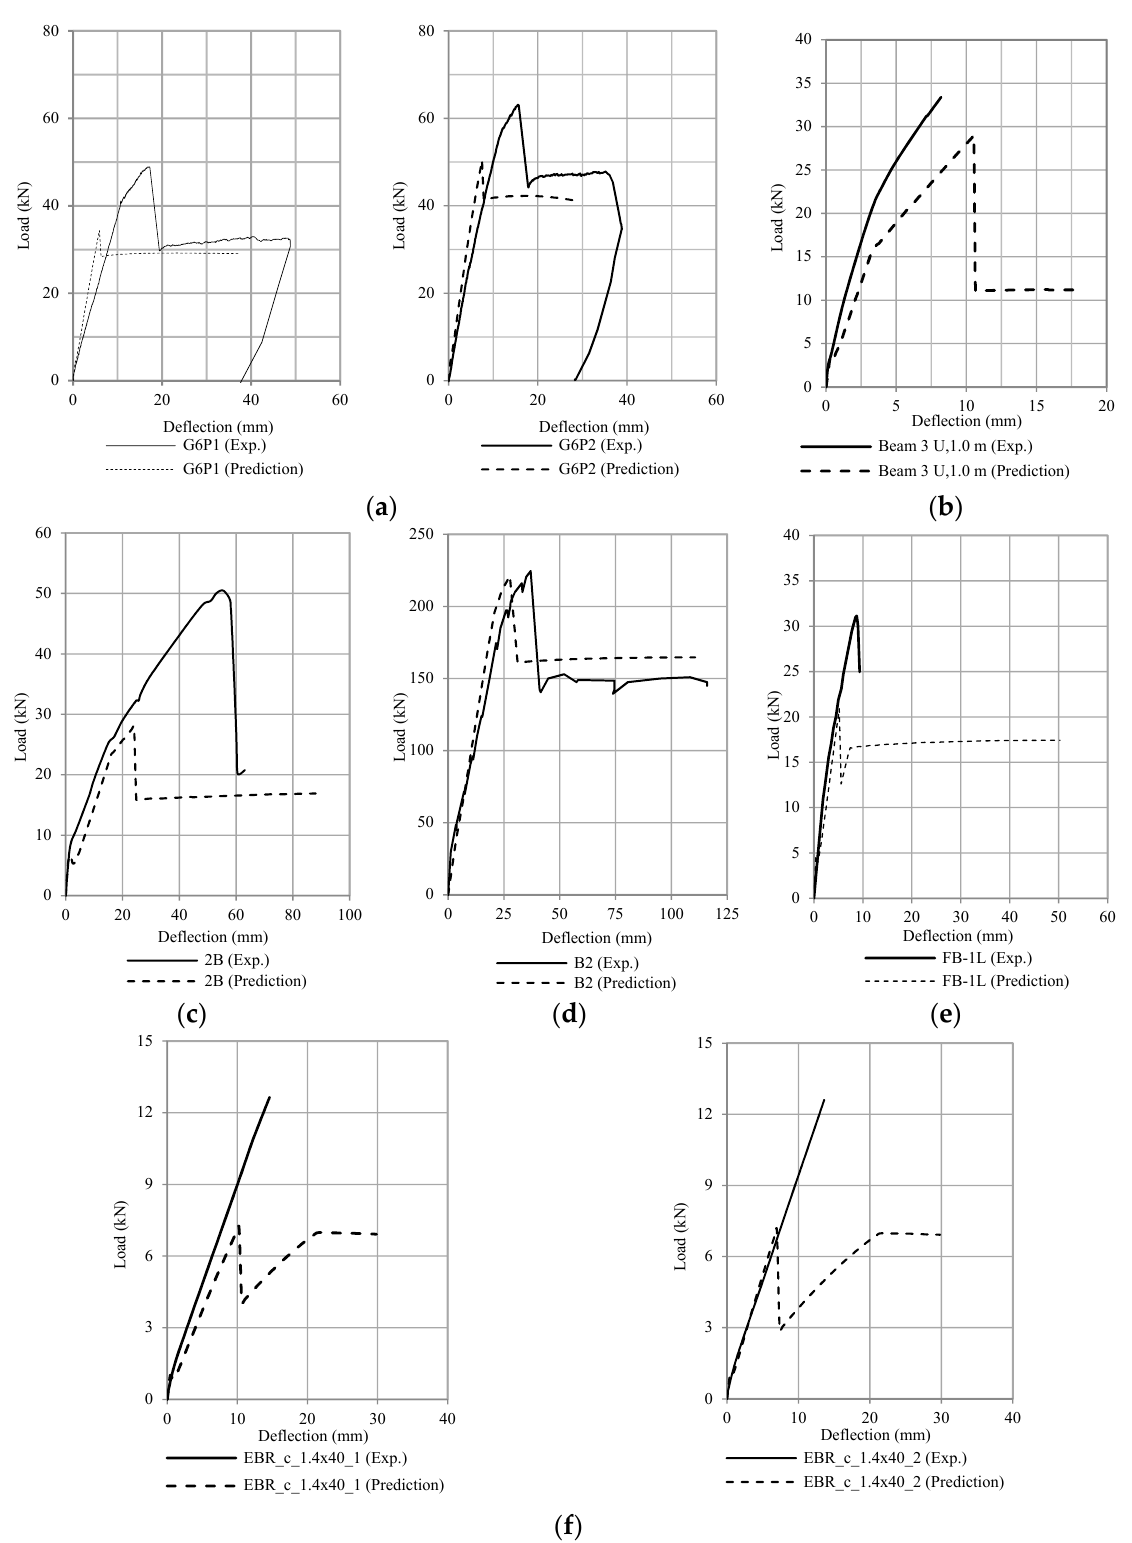
Figure 19. Comparison of the debonding load between the experimental results and the prediction (Type 1 debonding failure occurs before the experimental debonding load and after the yielding of tensile reinforcement) ( a ) Thamrin et al. [1], ( b ) Garden & Hollaway [2], ( c ) Ross et al. [4], ( d ) Khomwan et al. [11], ( e ) Ahmed et al. [15], and ( f ) Bilotta et al. [16].